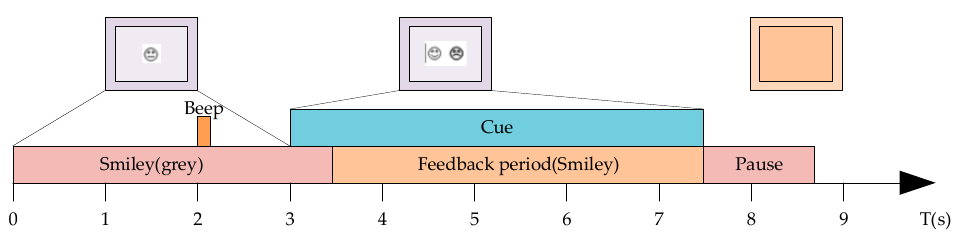
Figure 8. Feedback motion imagination without recognition results.